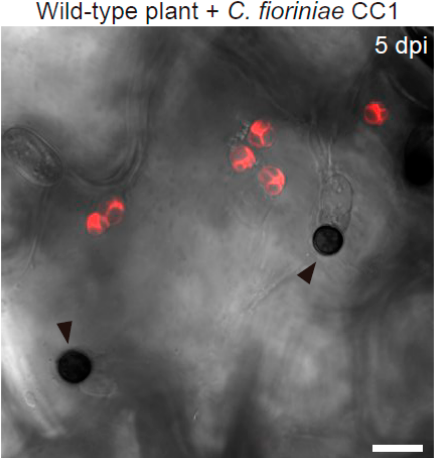
Figure 6. Enlargement of epidermal chloroplasts during ECR in A. thaliana . The epidermal surface of the wild-type plant inoculated with nonadapted C. fioriniae CC1 was investigated at 5 dpi. The chloroplasts were visualized based on chlorophyll autofluorescence. The DIC image was captured by confocal microscopy. The arrowheads indicate melanized appressoria. Scale bar, 10 µm.